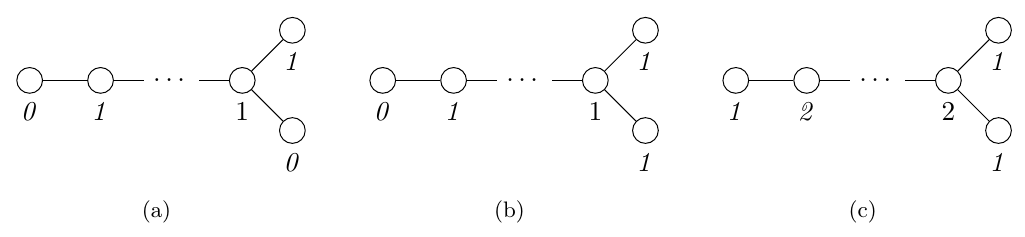
Figure 7 . Numbers represent topological charges at each